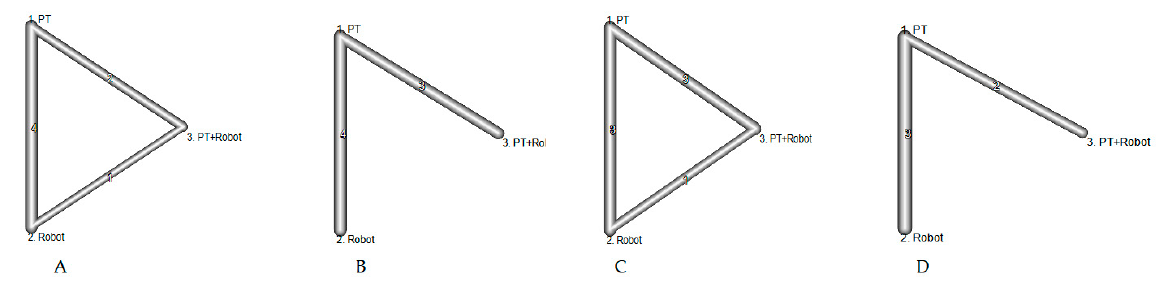
Figure 2. Comparisons of robot-assisted training vs. physiotherapy vs. physiotherapy + robot-assisted training:( A )gross motor function measure; ( B ) speed; ( C ) endurance; and ( D ) step length.